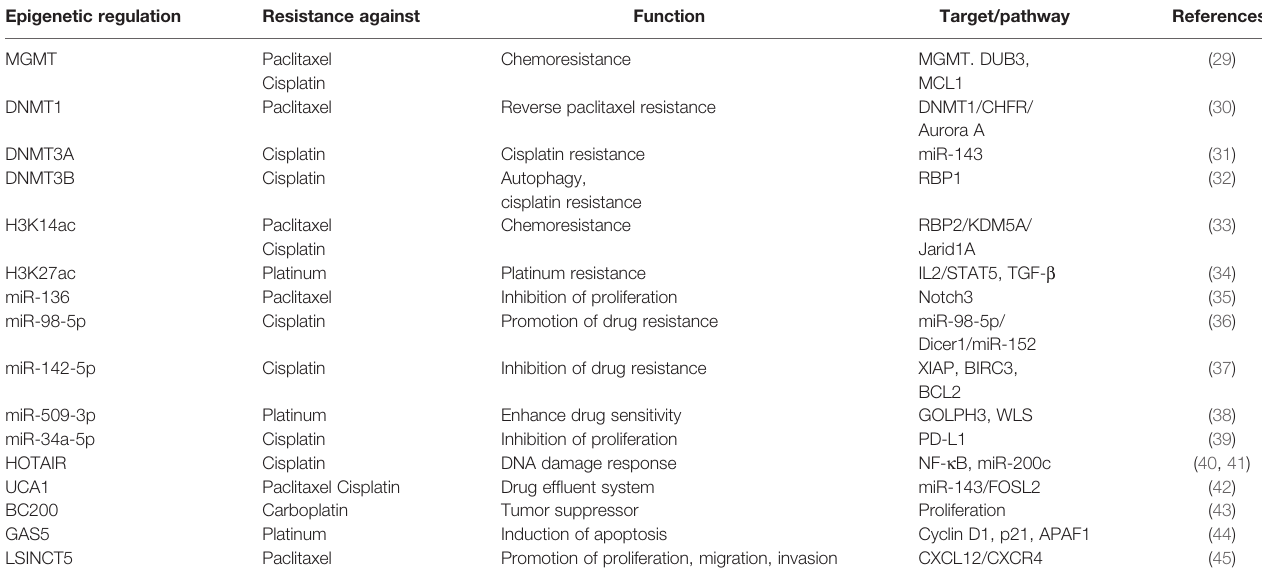
TABLE 1 | Summary of epigenetic regulation in OC drug resistance.